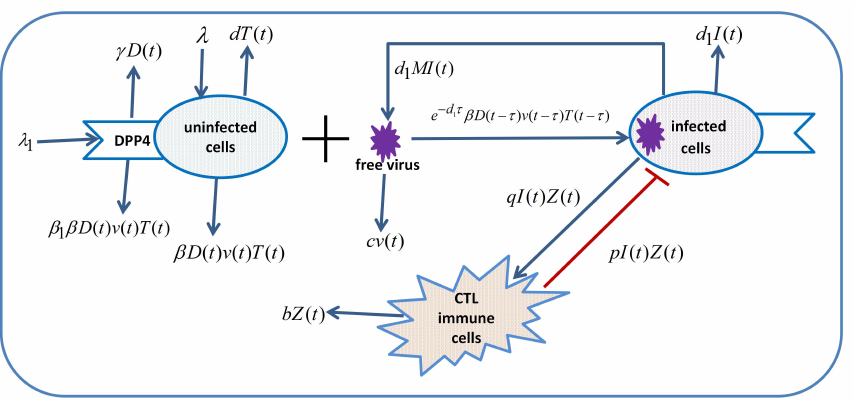
Figure 1. A schematic diagram of MERS-CoV infection with CTL immune response and intracellu- lar